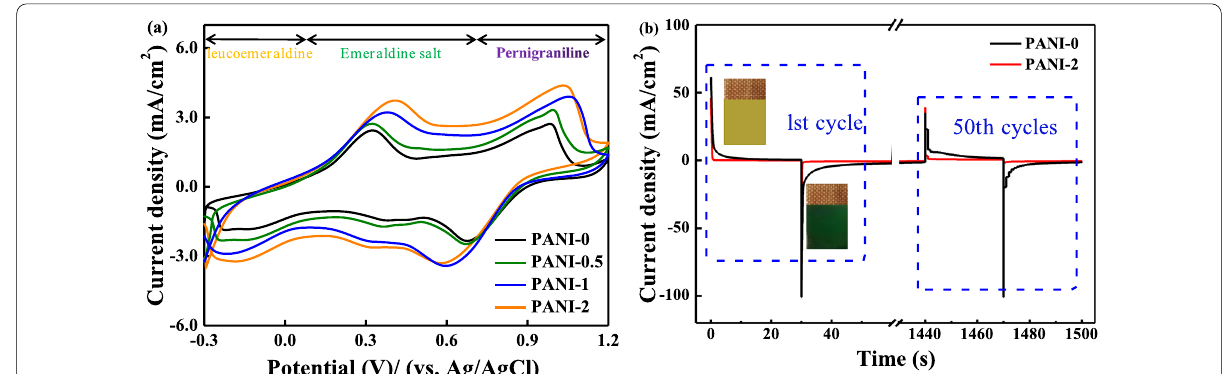
Fig. 7 a The CV curves of Cu-doped PANI porous films measured in 0.5 M H 2 SO 4 aqueous solutions with a scan rate of 50 mV/s sweeping between 0.3 and 1.2 V. b The CA curves of 1st and 50th cycles and digital camera images of the PANI-0 and PANI-2 porous films at 0.5 V and − 0.25 −